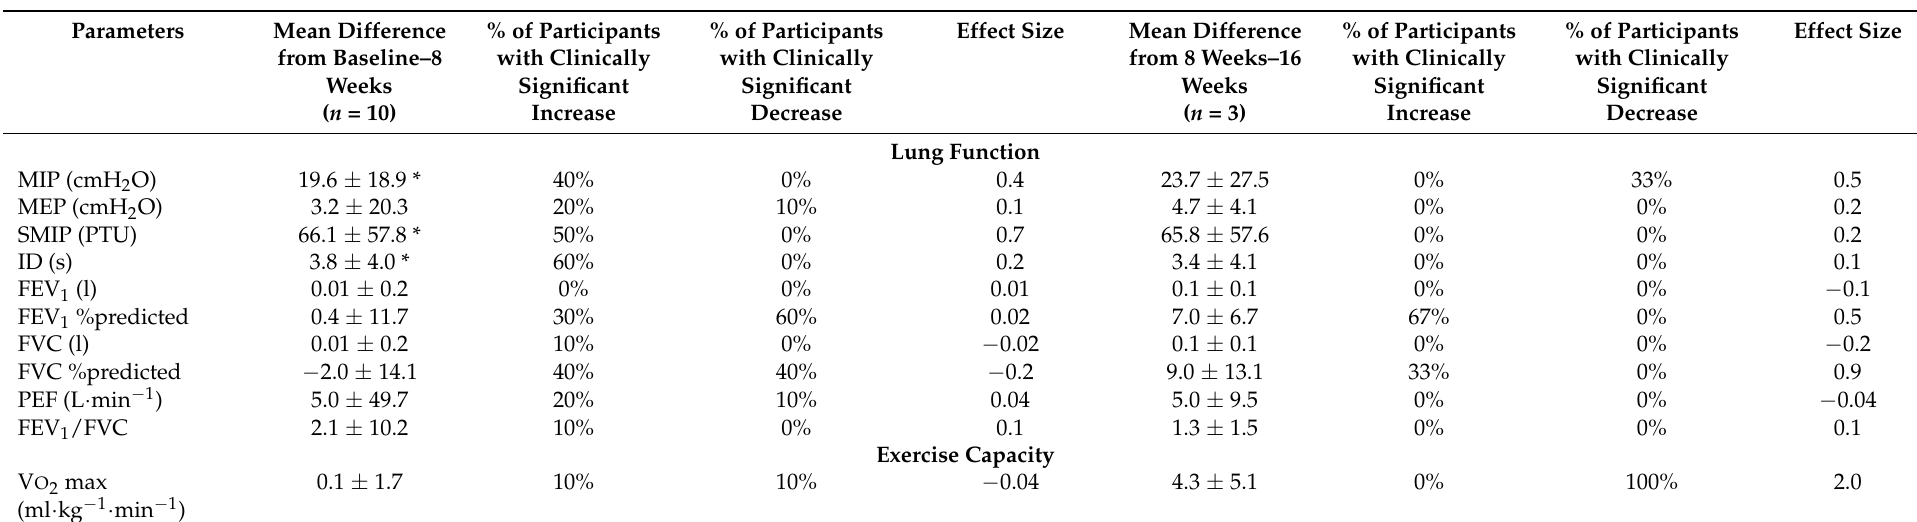
Table 2. Meaningful clinical difference between baseline, eight weeks and 16 weeks in adults with